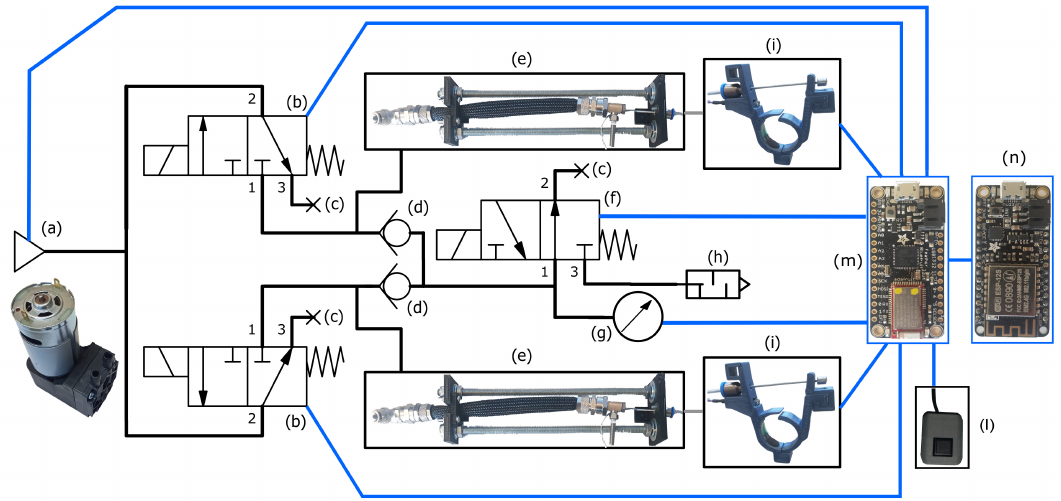
Figure 4. Schematic of the pneumatic control system. ( a ) Pressure Source. ( b ) Normally-closed servovalve. ( c ) Closed port. ( d ) One-way valve. ( e ) PAM. ( f ) Normally-open servovalve. ( g ) Pressure sensor. ( h ) Silencer. ( i ) Actuator ring. ( l ) Patient’s push-button. ( m ) Embedded-control board Feather Bluefruit 32u4. ( n ) Board Feather Huzzah with ESP8266